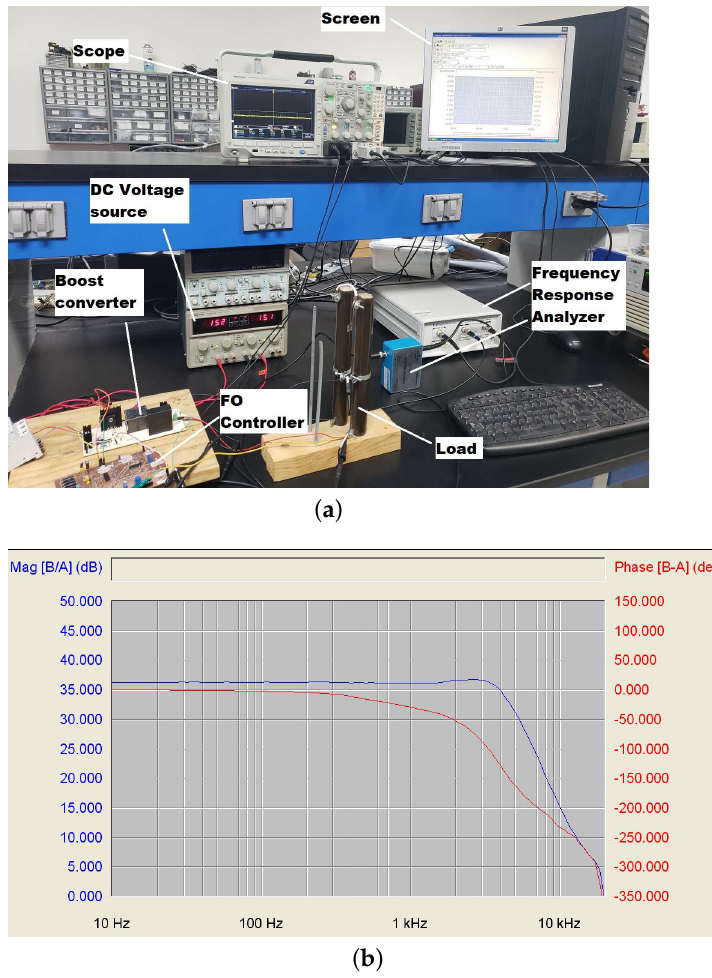
Figure 11. Frequency response of the proposed PID controller approximation. ( a ) Worktable with the equipment for the experiment. ( b ) Experimental measurement of controller phase contribution from the arrangement in Figure 6 obtained with the Frequency Response Analyzer, Model 300, 0.01Hz/30MHz, AP